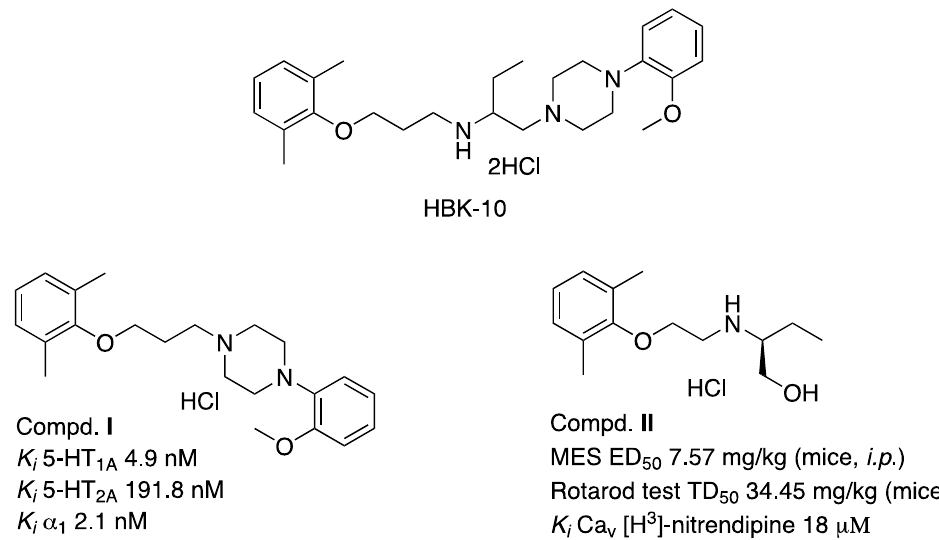
Figure 1. The structure of HBK-10 and the reference compounds I and II [14,17] .